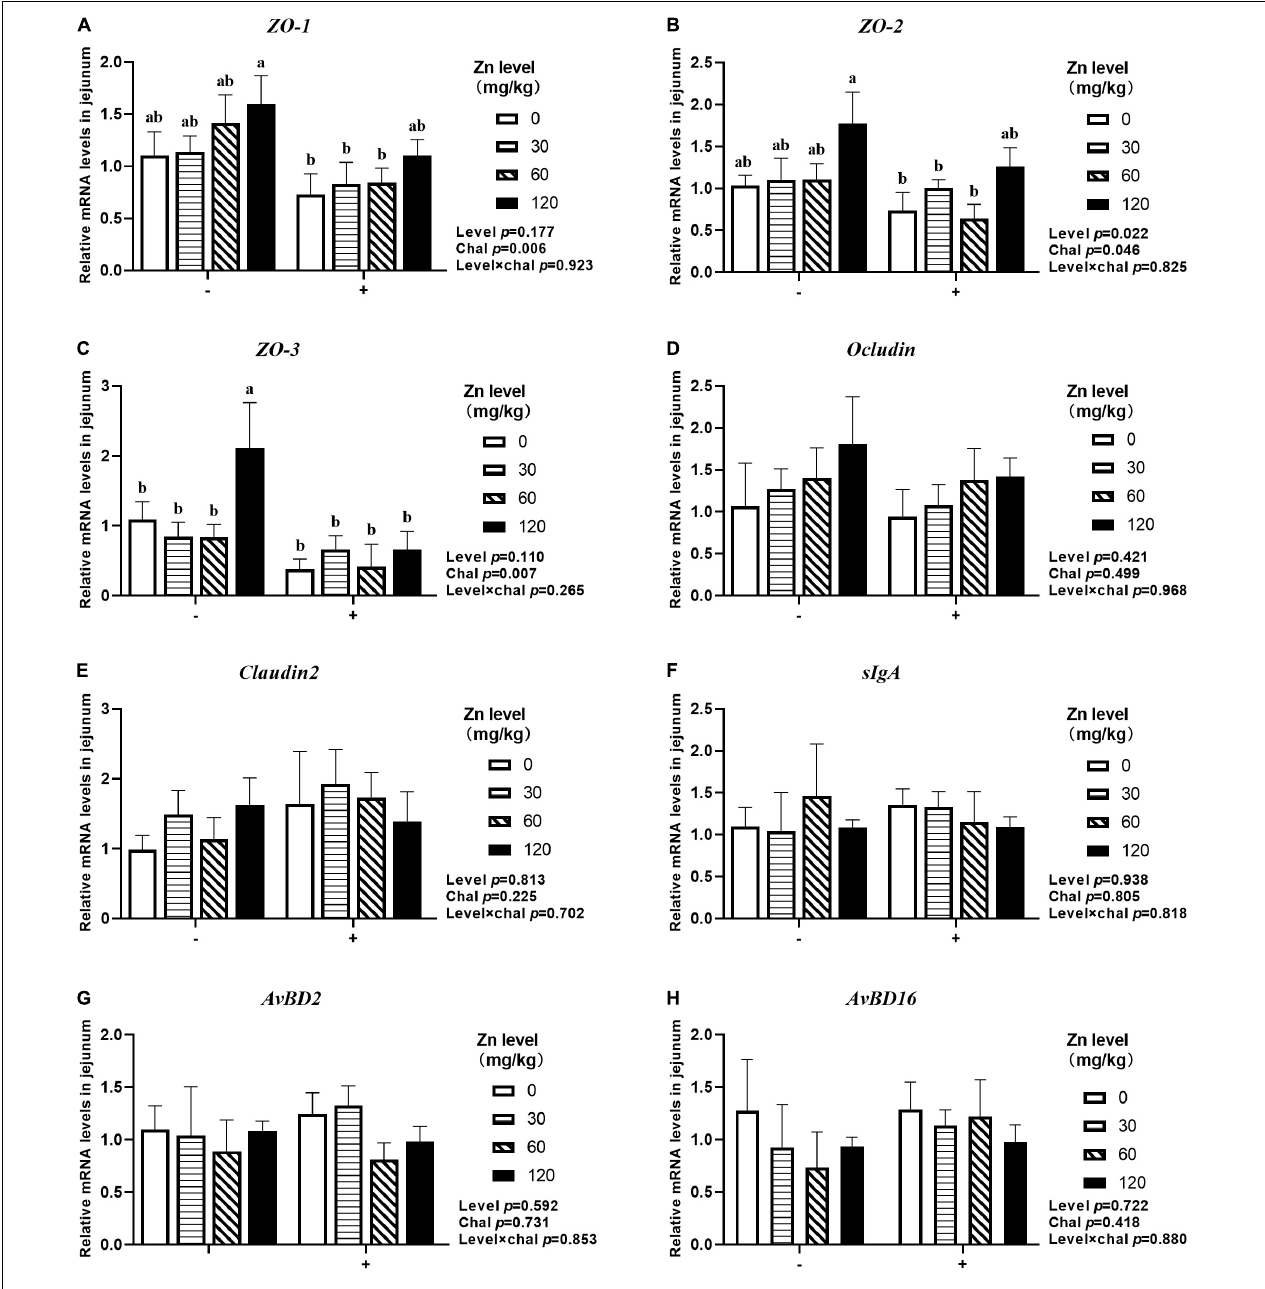
FIGURE 8 | Effect of dietary Zn–Met levels on the mRNA expression of barrier-related gene ZO-1 (A) , ZO-2 (B) , ZO-3 (C) , Occludin (D) , Claudin2 (E) , sIgA (F) , AvBD2 (G) and AvBD16 (H) in jejunum of meat duck challenged with APEC (8 DPI). Bars with different letters are statistically significant ( P < 0.05). Results are expressed as mean ± SEM ( n =